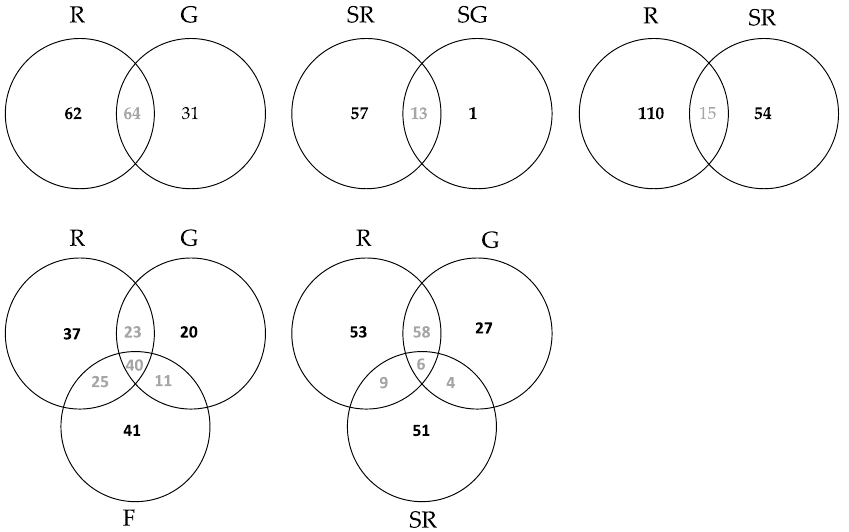
Figure 3. Total OTU number within and shared among groups using high throughput Illumina sequencing. R = Roosky leaves, G = Glasnevin leaves, F = France leaves; SR = Seeds Roosky, SG = Seeds Glasnevin.